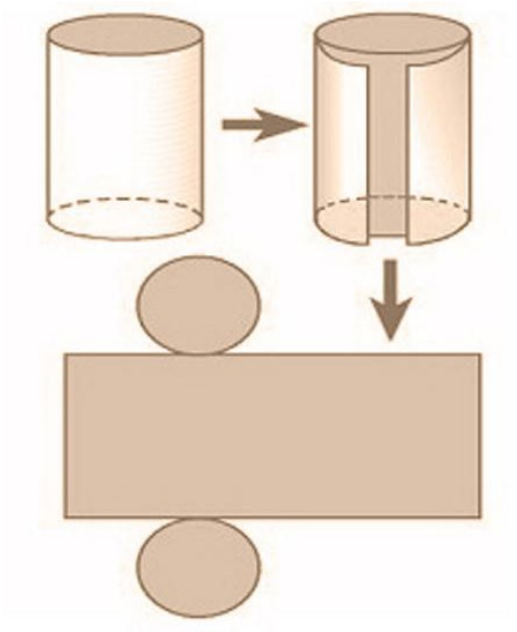
Figure 7. Process of unfolding the envelope of a cylinder in a flat projection